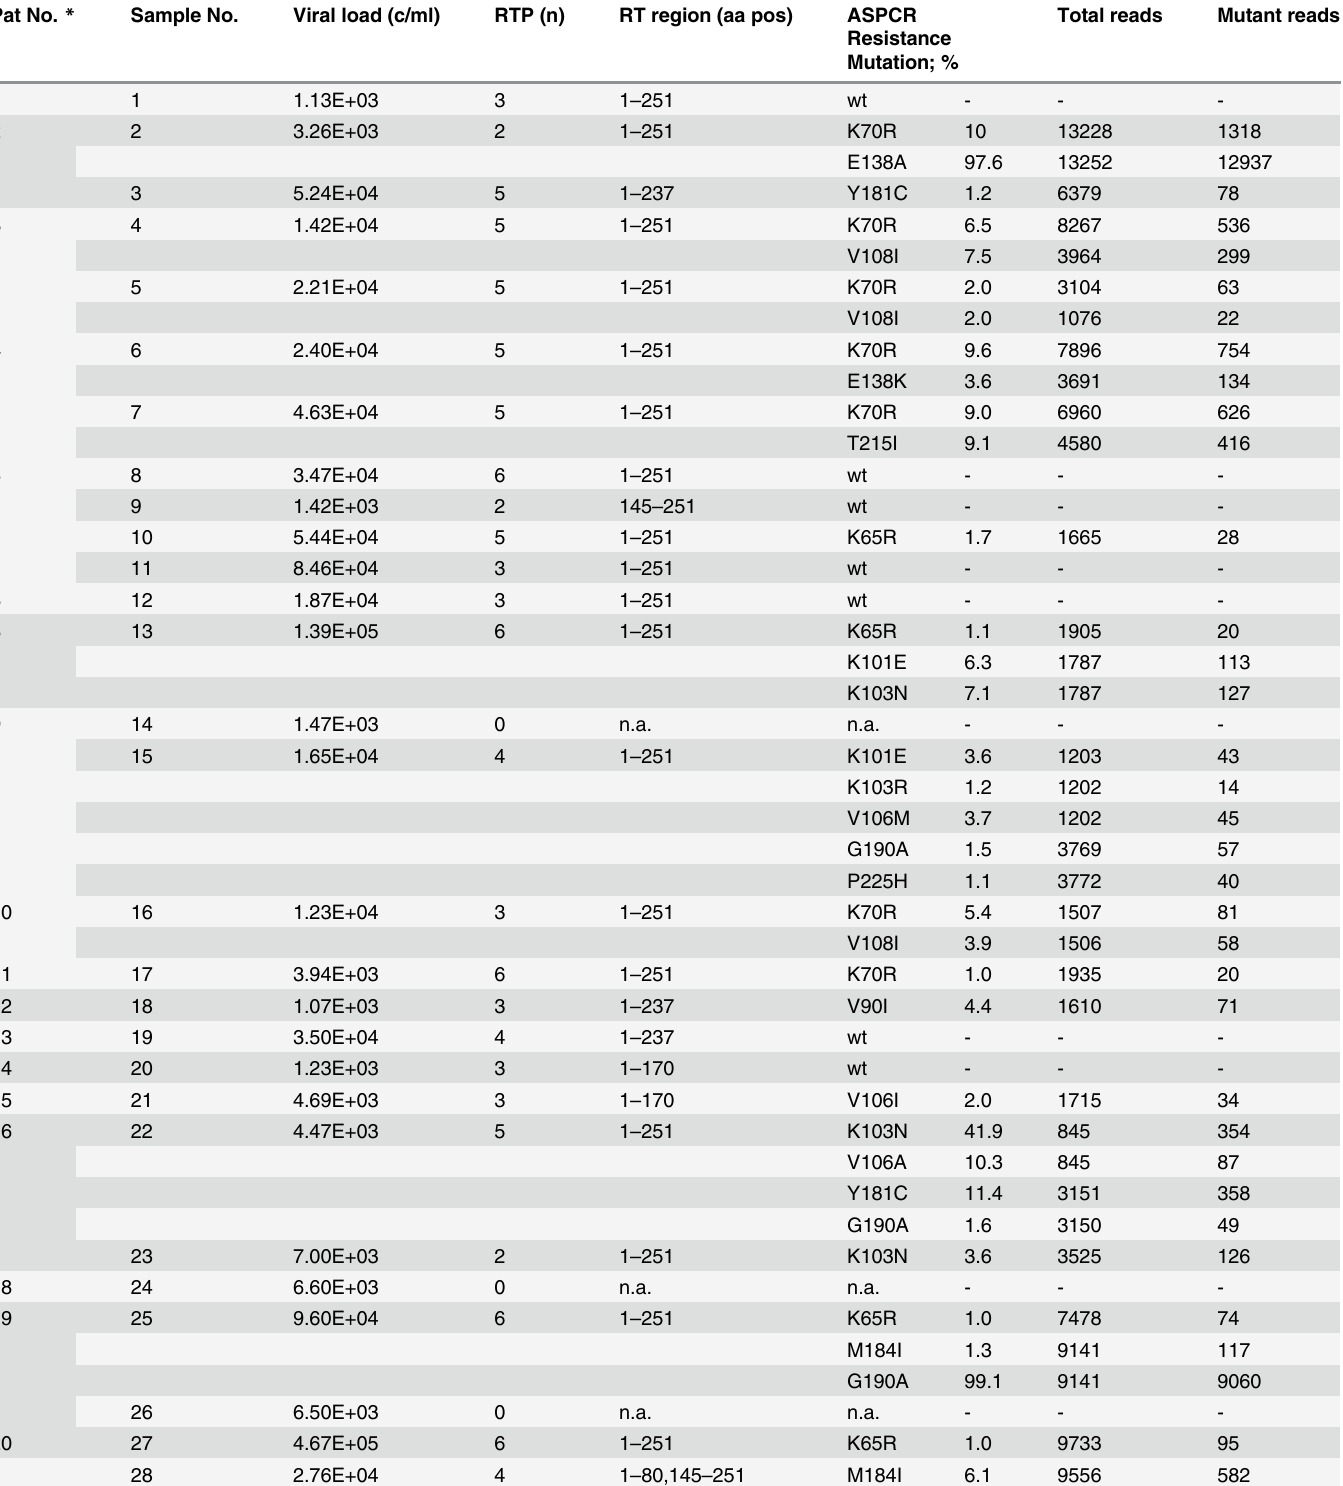
Table 2. Outcome of UDS amplicon generation and sequencing regarding detection of drug-resistant (AZT, 3TC, NVP) HIV-1 variants. Pat No. * Sample